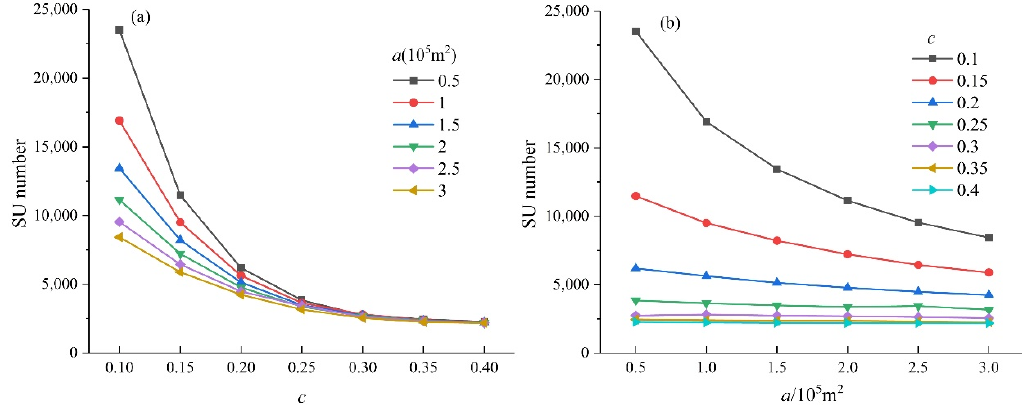
Figure 8. The number of slope units with different ( a ) a and ( b ) c values.